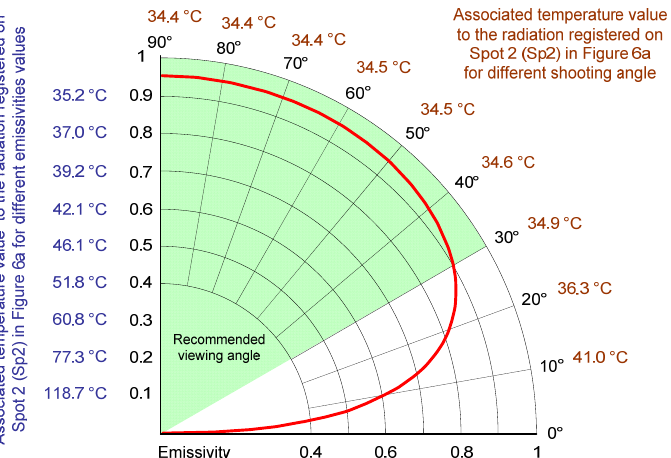
Figure 5. Dependence of the emissivity of the battery pack and influence of emissivity changes on the temperature displayed by the thermal camera.